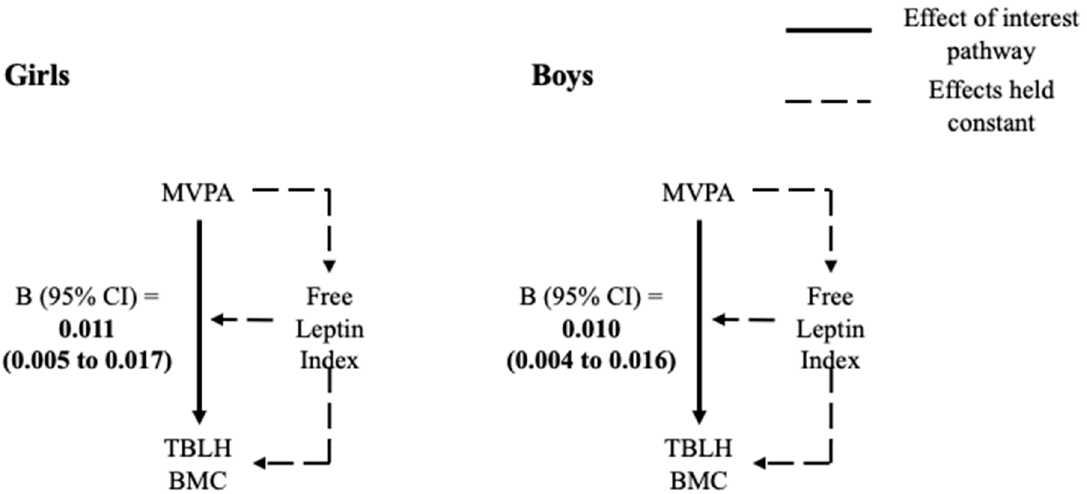
Figure 3. Controlled direct effect of MVPA on TBLH BMC from the 4-way decomposition model for girls and boys. Moderate-to-vigorous physical activity, MVPA; total body less head bone mineral content, TBLH BMC. Models adjusted for age, body height and TBLH fat mass.